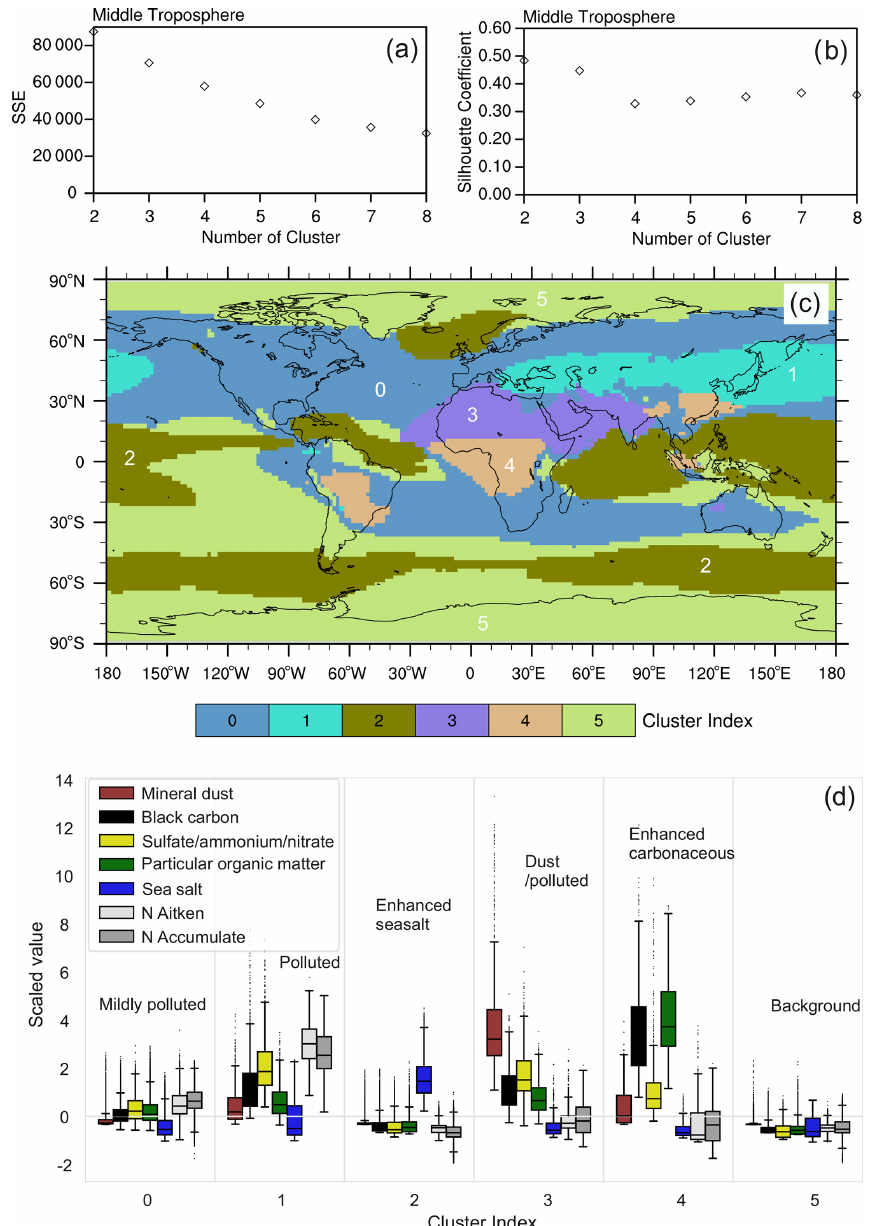
Figure 4. The same as Fig. 2 but for the middle troposphere (from ∼ 700 to ∼